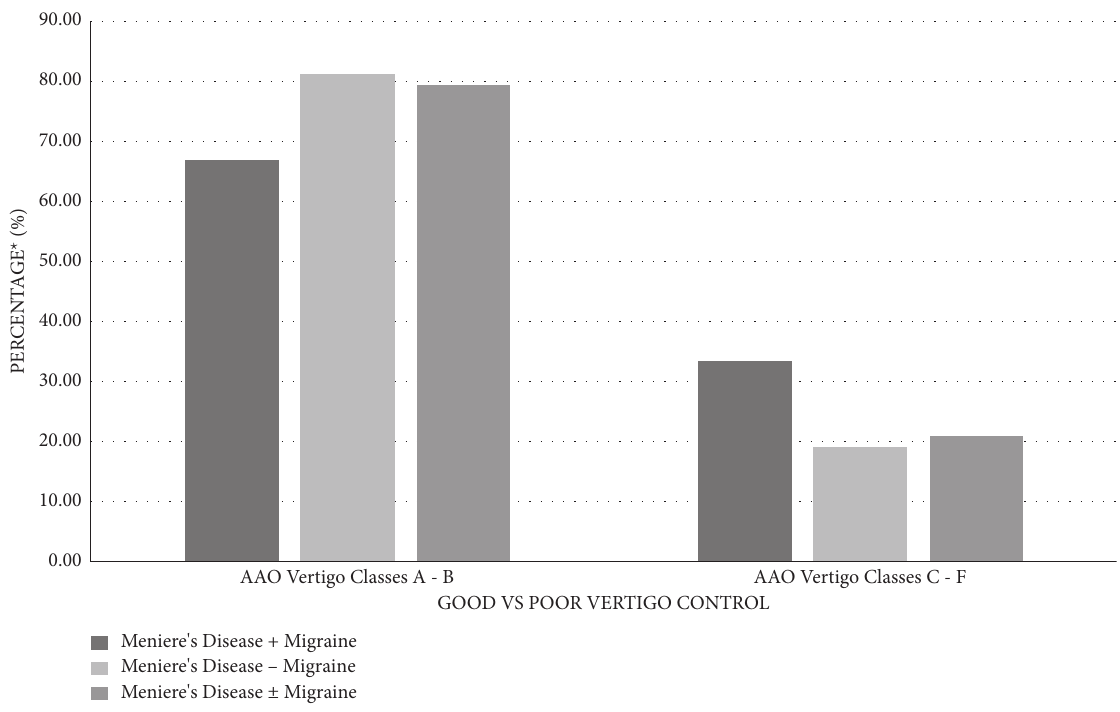
Figure 2: Vertigo control following endolymphatic sac surgery. Good control was defined as AAO classes A-B. Poor control was defined as AAO classes C–F. ∗ Based on specific population sizes for each respective patient category. See Tables 2 and 3 for numerical representation of